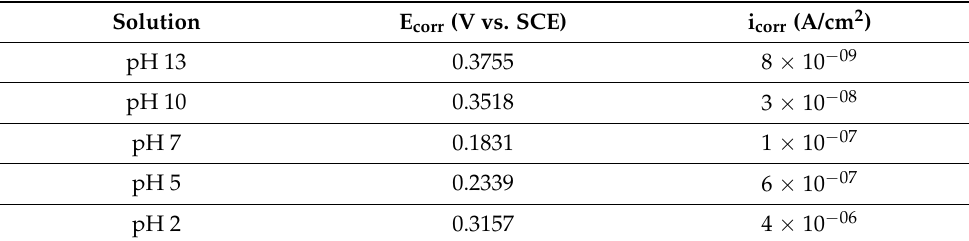
Table 4. Ecorr and icorr value of welded duplex 2205 Stainless-Steel in different pH solution.